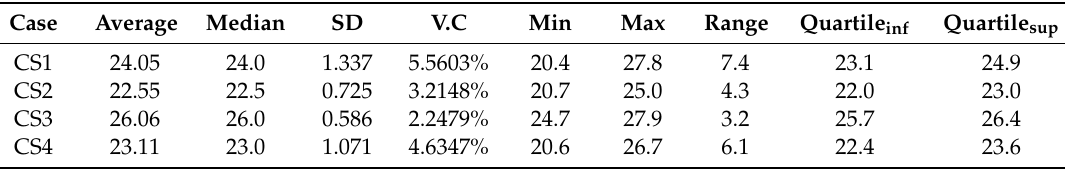
Table 4. Temperature statistics ( ◦ C) before home confinement (lockdown). V.C., variation coe ffi cient.